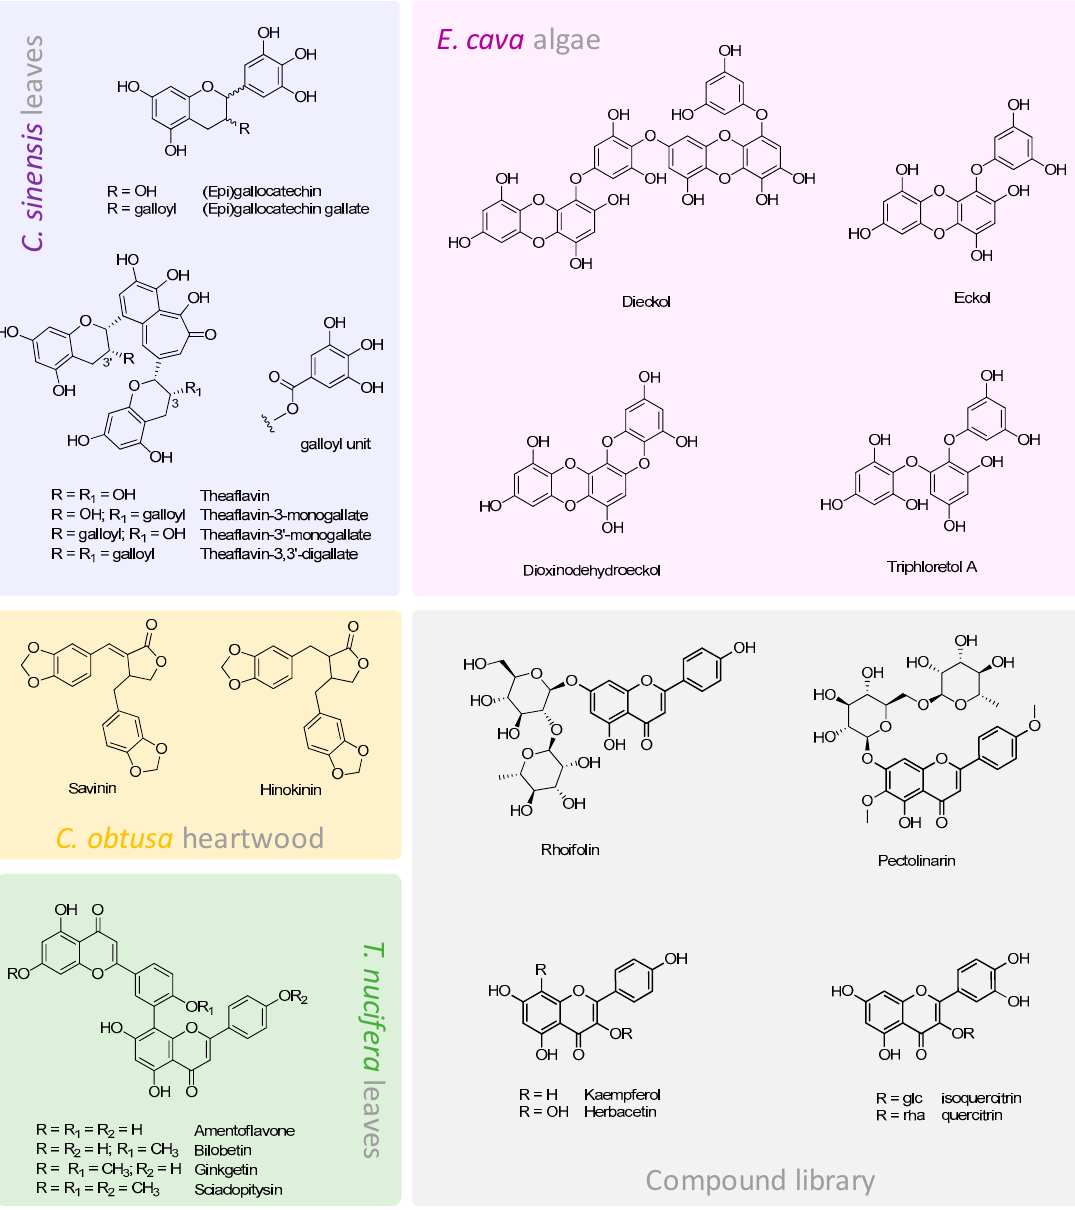
Figure 7. Chemical structures and related sources of some promising natural compounds against 3CLpro.